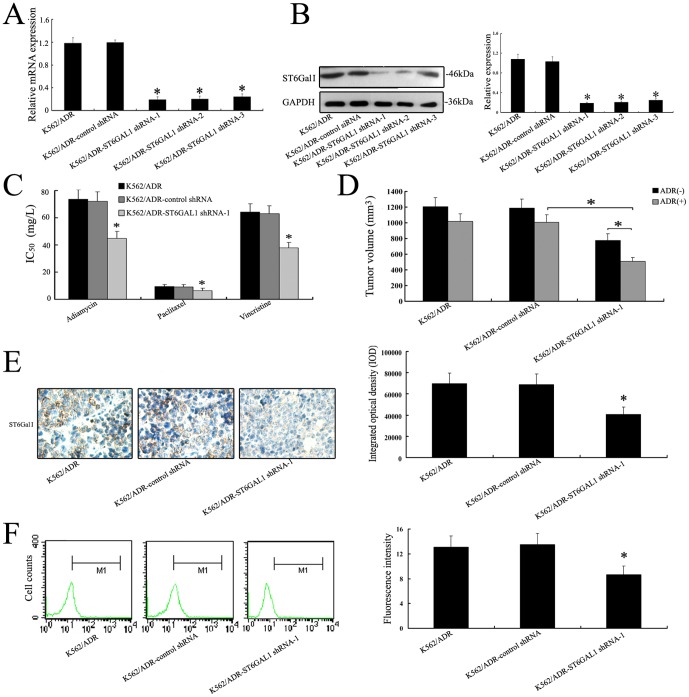
Silence of ST6GAL1 gene enhances the chemosensitivity of K562/ADR cell both in vitro and in vivo.(A) ST6GAL1 transcript was decreased apparently in K562/ADR cells by shRNA treatment. (B) After shRNA transfection, distinct reduction of ST6Gal 1 was observed at protein levels by western blotting analysis. (C) Cell chemosensitivity was assessed by cytotoxicity assays. The reported values are the IC50 (Mean ± SD) of three independent experiments. IC50 represents the drug concentration producing 50% decrease of cell growth. *P<0.05 vs K562/ADR-control shRNA cells. (D) When exposed to adriamycin, the tumor volume of nude mice bearing K562/ADR-ST6GAL1 shRNA-1 xenograft was significantly diminished (*P<0.05). (E) Down-regulation of ST6GAL1 was also shown by IHC staining in xenograft tumors derived from K562/ADR-ST6GAL1 shRNA-1 cells (400×). (F) Flow cytometry analysis showed a lower expression of ST6GAL1 in K562/ADR cells with ST6GAL1 transfection. The data are means ± SD of 3 independent assays (*P<0.05).